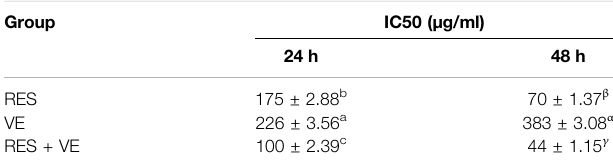
TABLE 1 | Effects of RES, VE and their combination on the proliferation activity of HCT-8 cell. Group